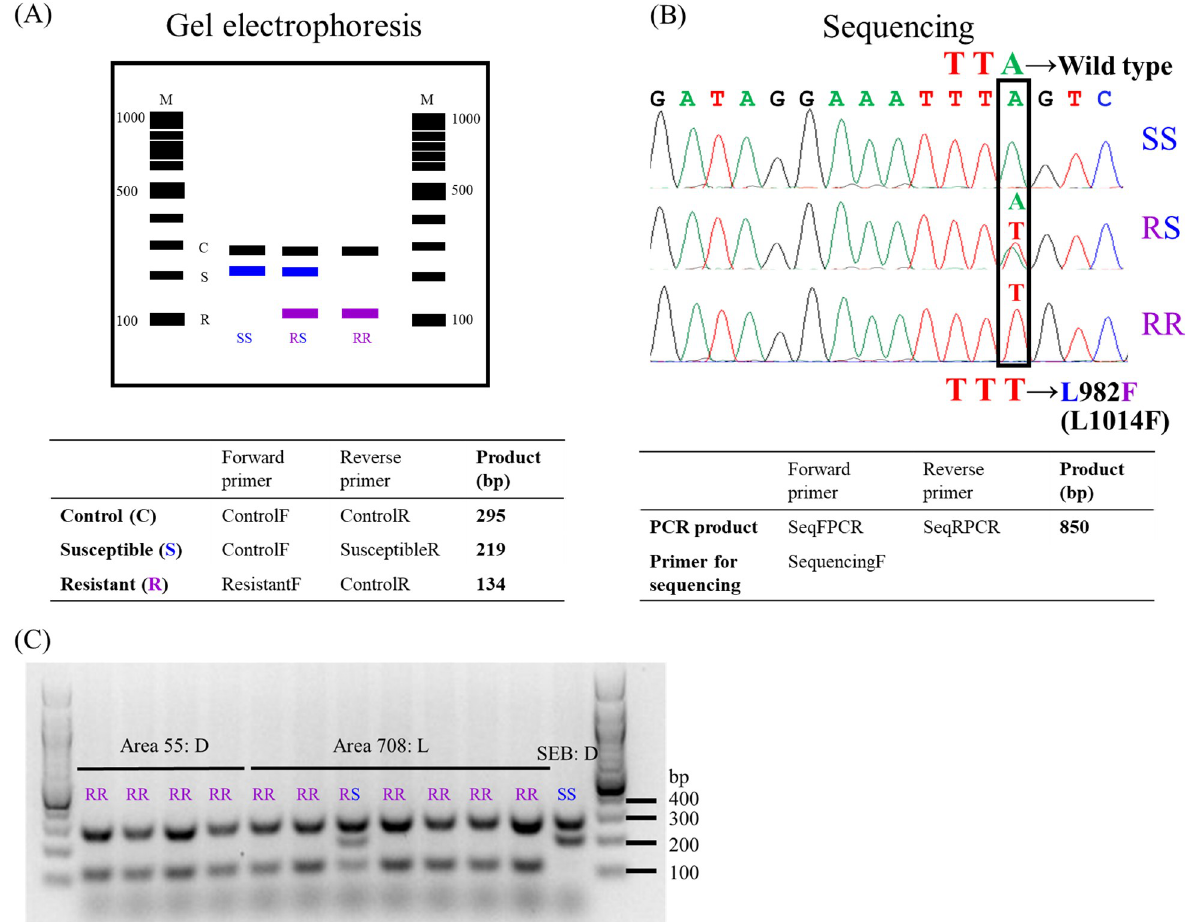
Fig 6. Diagnostic methods for detection of the kdr -like mutation in the voltage-gated sodium channel (Na v ). (A) Schematic of the diagnostic PCR expected products for detecting the single nucleotide polymorphism (SNP) A (susceptible allele) to T (resistant allele), as resolved on a 1.5% agarose gel. The A to T mutation results in the nonsynonymous L982F mutation in the protein. The ControlF and ControlR primers amplify a 295 bp “control band” product (black) that is expected from all mosquitoes (S1 Fig), the ControlF and SusceptibleR primers amplify a 219 bp “susceptible band” product (blue) only if at least one susceptible allele is present, and the ResistantF and ControlR set amplify a 134 bp “resistant band” product (purple) only if at least one kdr resistant allele is present. (B) The wild type, susceptible codon TTA changes to TTT in the kdr resistant allele (black rectangle) resulting in the sodium channel L982F mutation. Electropherograms of three different genotypes. Top: homozygous susceptible SS (TTA); middle: heterozygous RS (TTA/TTT); and bottom: homozygous resistant mosquitoes RR (TTT) for the L982F mutation. The kdr -like mutation amino acid residue position in the sodium channel of the house fly is shown in parenthesis. (C) Diagnostic PCR results of field collected mosquitoes from areas 55 and 708, and Sebring strain (SEB) mosquitoes from 91.2 m. D, mosquitoes were dead after Permanone 1 treatment; L, alive after Permanone 1